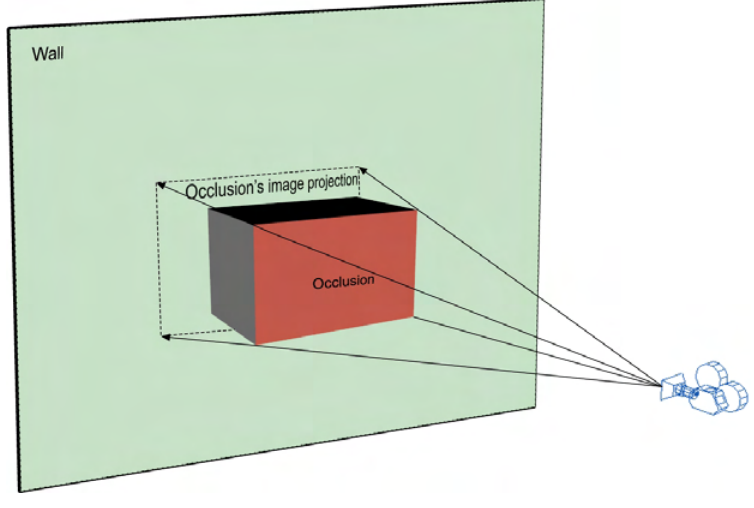
Figure 11. An occlusion and its central perspective projection on a